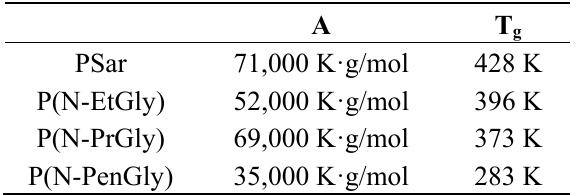
Table 1. Parameters used Flory-Fox equation to obtain